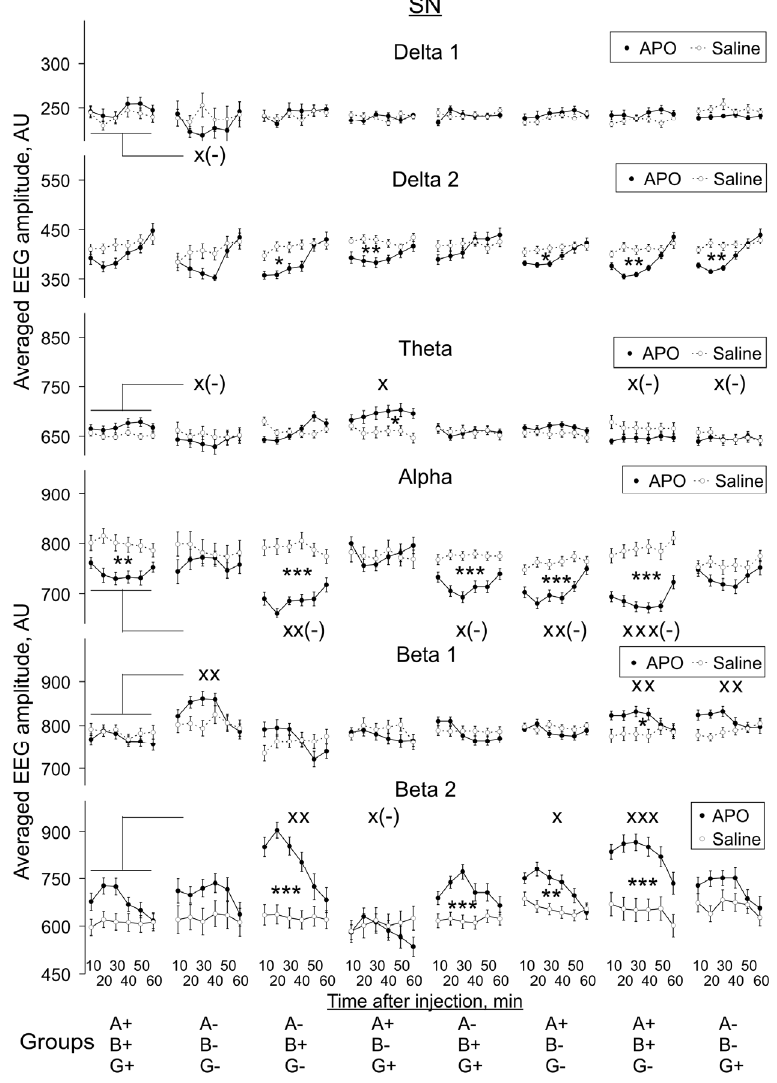
Figure 8. Evolution of apomorphine (APO, 1.0 mg/kg, s.c.) vs. saline effects in “classical” frequency bands of 12 s fragments of EEG from SN averaged for consecutive 10 min intervals (abscissa) in knockout mice of different types. Ordinate is the averaged absolute values of EEG amplitudes in each of the “classical” bands, in arbitrary units (vertical lines are ± 1 SEM), obtained in experiments with saline and APO (grey and black lines, respectively) in each group. Differences between baseline EEGs in knockout and wild-type mice were used to normalise the APO effects in knockout groups to those in control. Symbols * and x denote the significant differences of APO vs. saline and knockout mice vs. wild-type control, respectively (one, two and three symbols denote p < 0.05, <0.01 and 0.001, respectively). Symbol x(-) denotes the significant enhancement of the APO suppressive effect, for clarity.